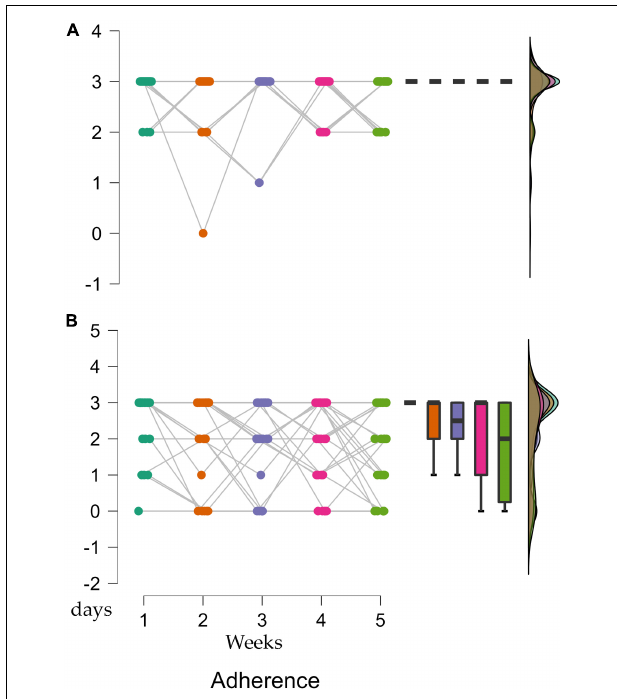
FIGURE 5 | (A) Adherence during the supervised period. (B) Adherence during the online period. Weekly adherence in the supervised (weeks 1–5) and online (weeks 6–10) periods. Differences were only present during the online training period.